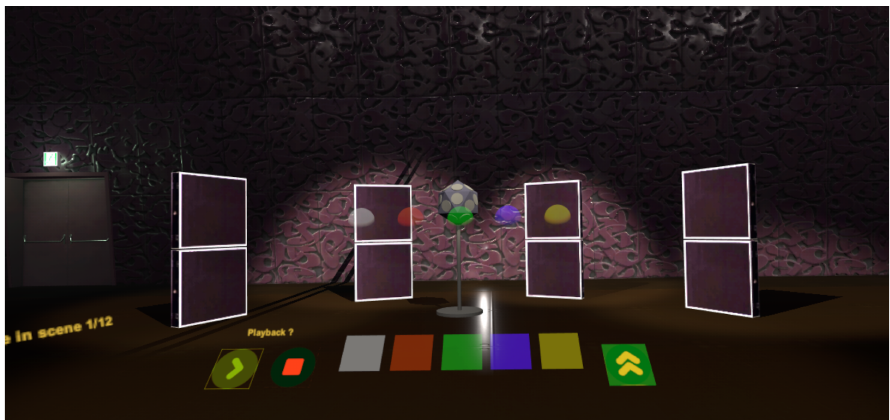
Figure 6. Screen shot of VR-rendered environment. Listener faces icosahedral loudspeaker (IKO) and uses controller to switch between conditions when moved over colored floor panels and to drag-and-drop place correspondingly colored auditory event markers (opaque/translucent for